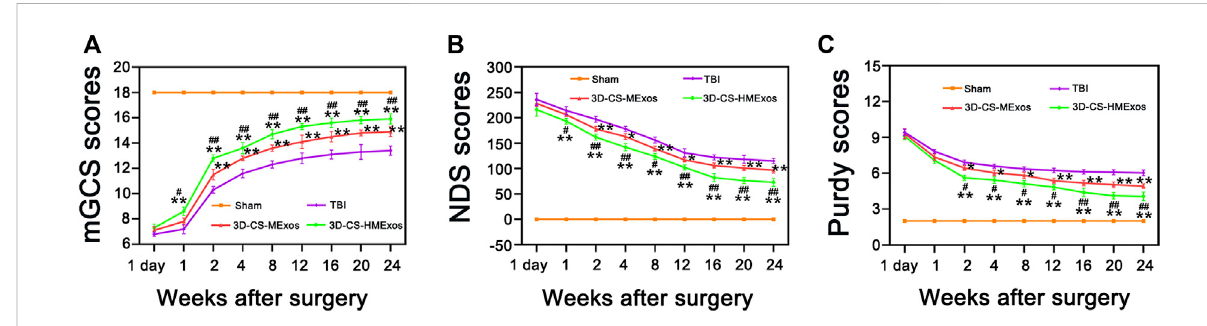
FIGURE 4 Hypoxia-inducedexosomescombinedwith3D-printedcollagenandsilk fi